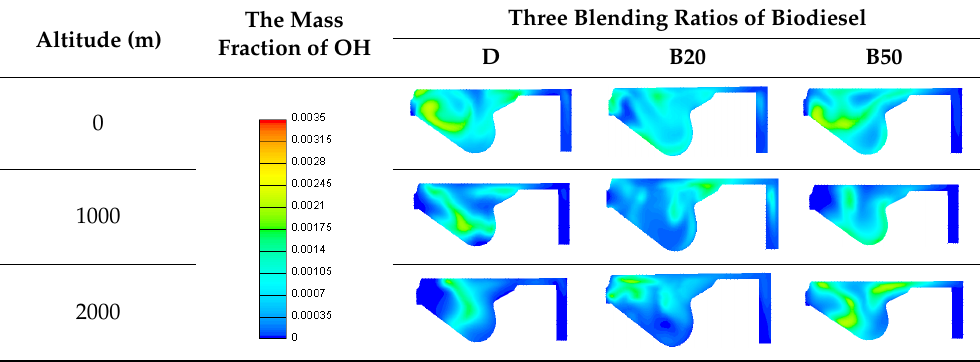
Table 3. Effect of different plateau environments on OH distribution field of cylinder with three blending ratios. Altitude (m) The Mass Fraction of OH